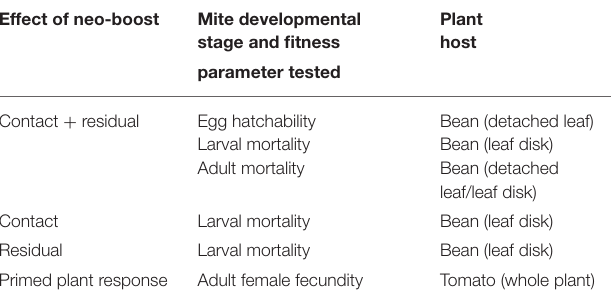
TABLE 1 | Spray regimes for testing combined contact and residual, contact, residual, and priming effects of